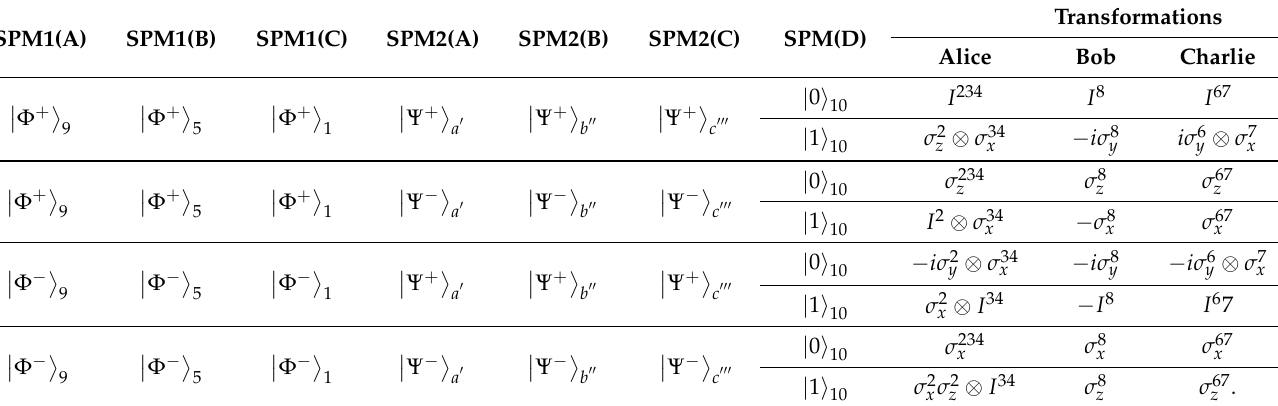
Table 1. Joint collapsed states of some cases and reconstructed unitary